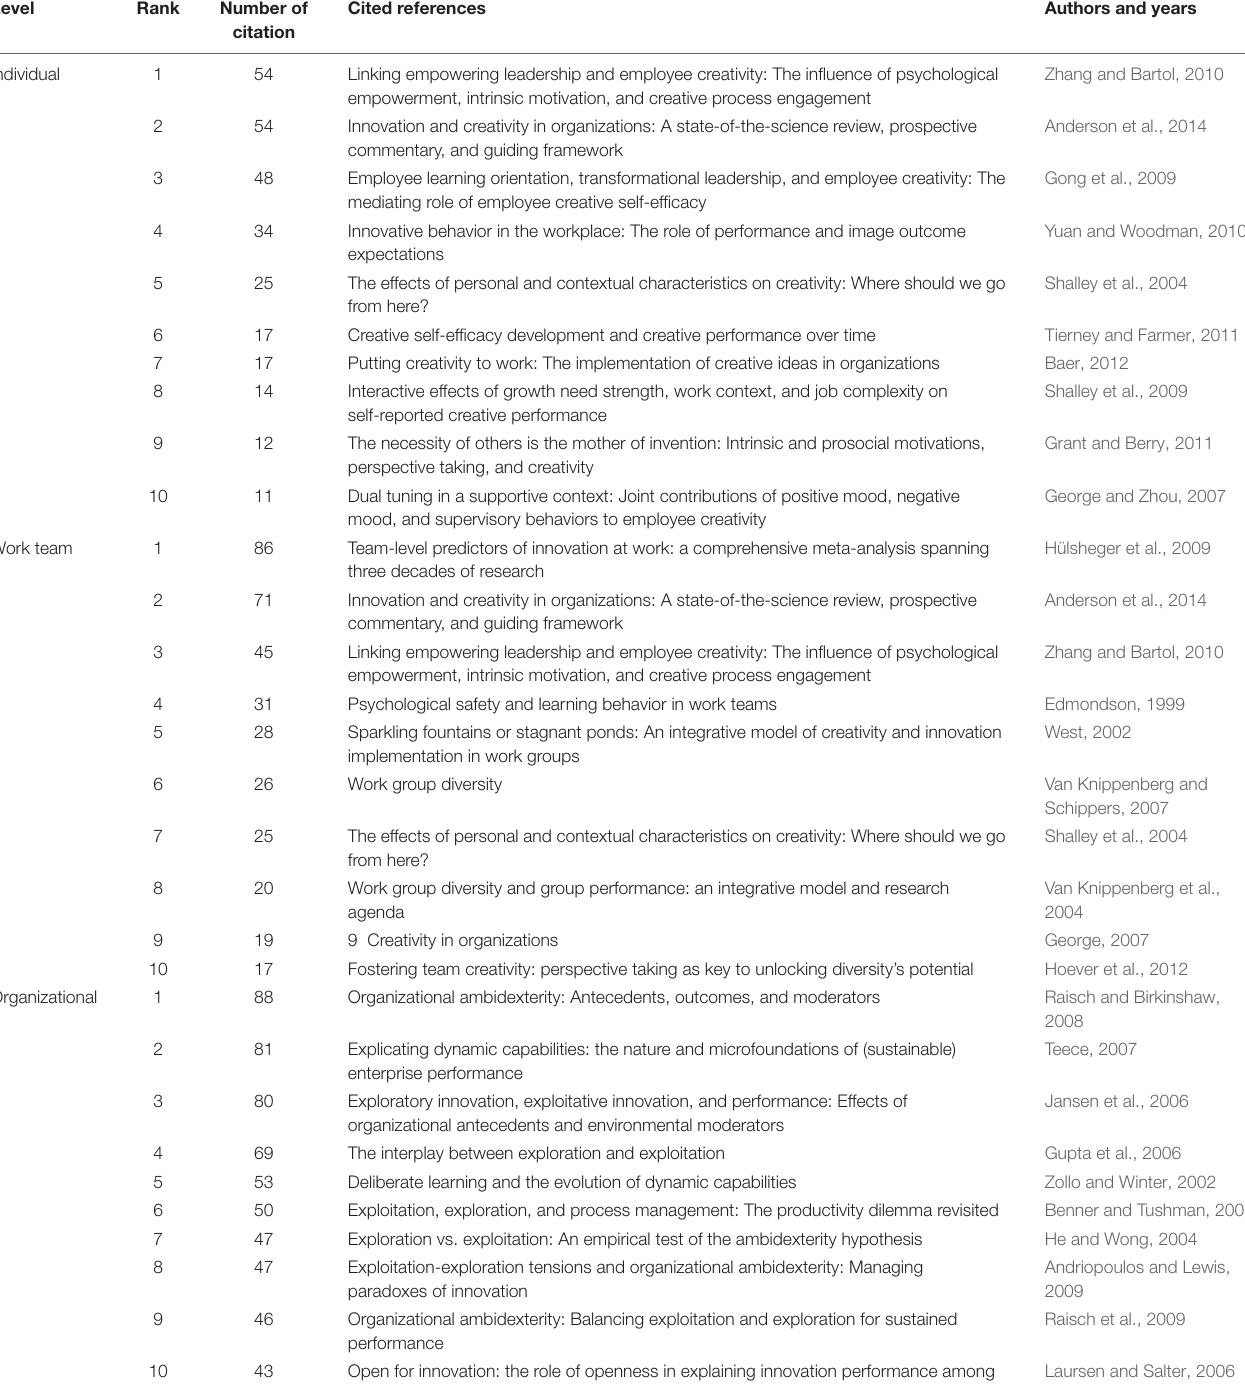
TABLE 4 | Top 10 highly cited references of innovation research at different